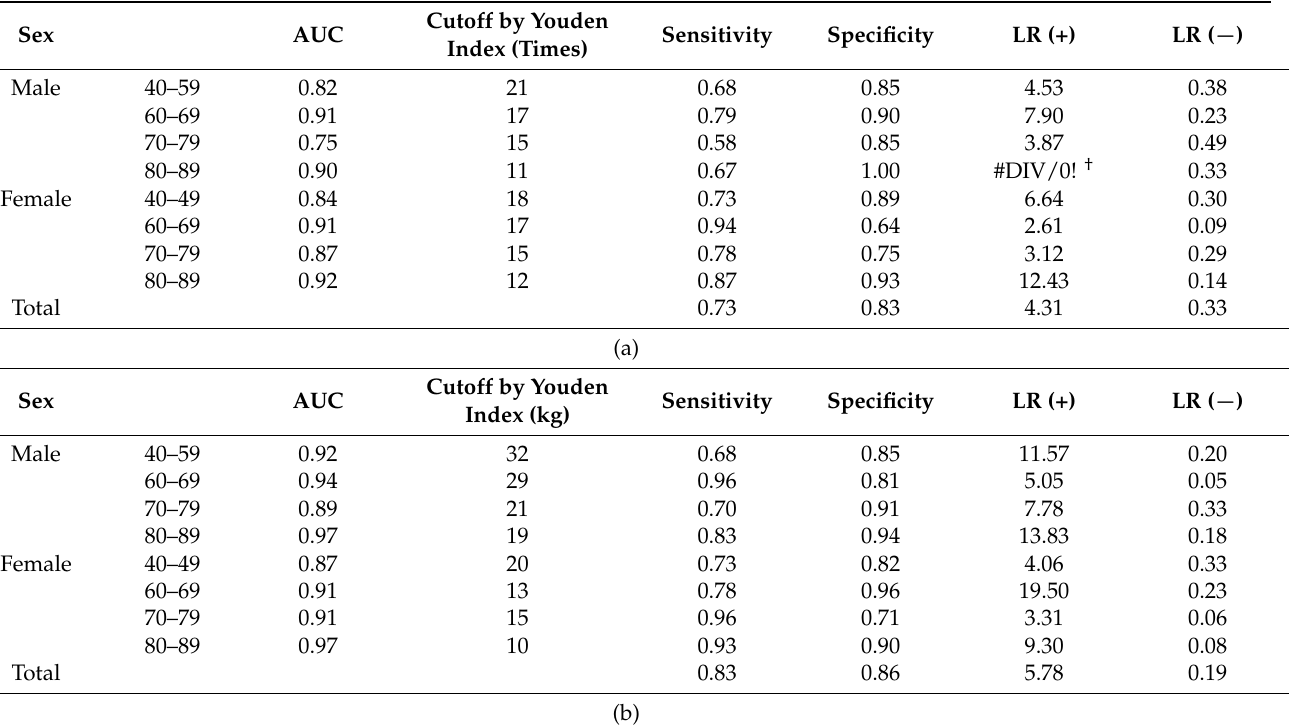
Table 2. ( a ). Area under the curve for the grip and release test in the screening of DCM. ( b ). Area under the curve for the grip test in the screening of DCM.